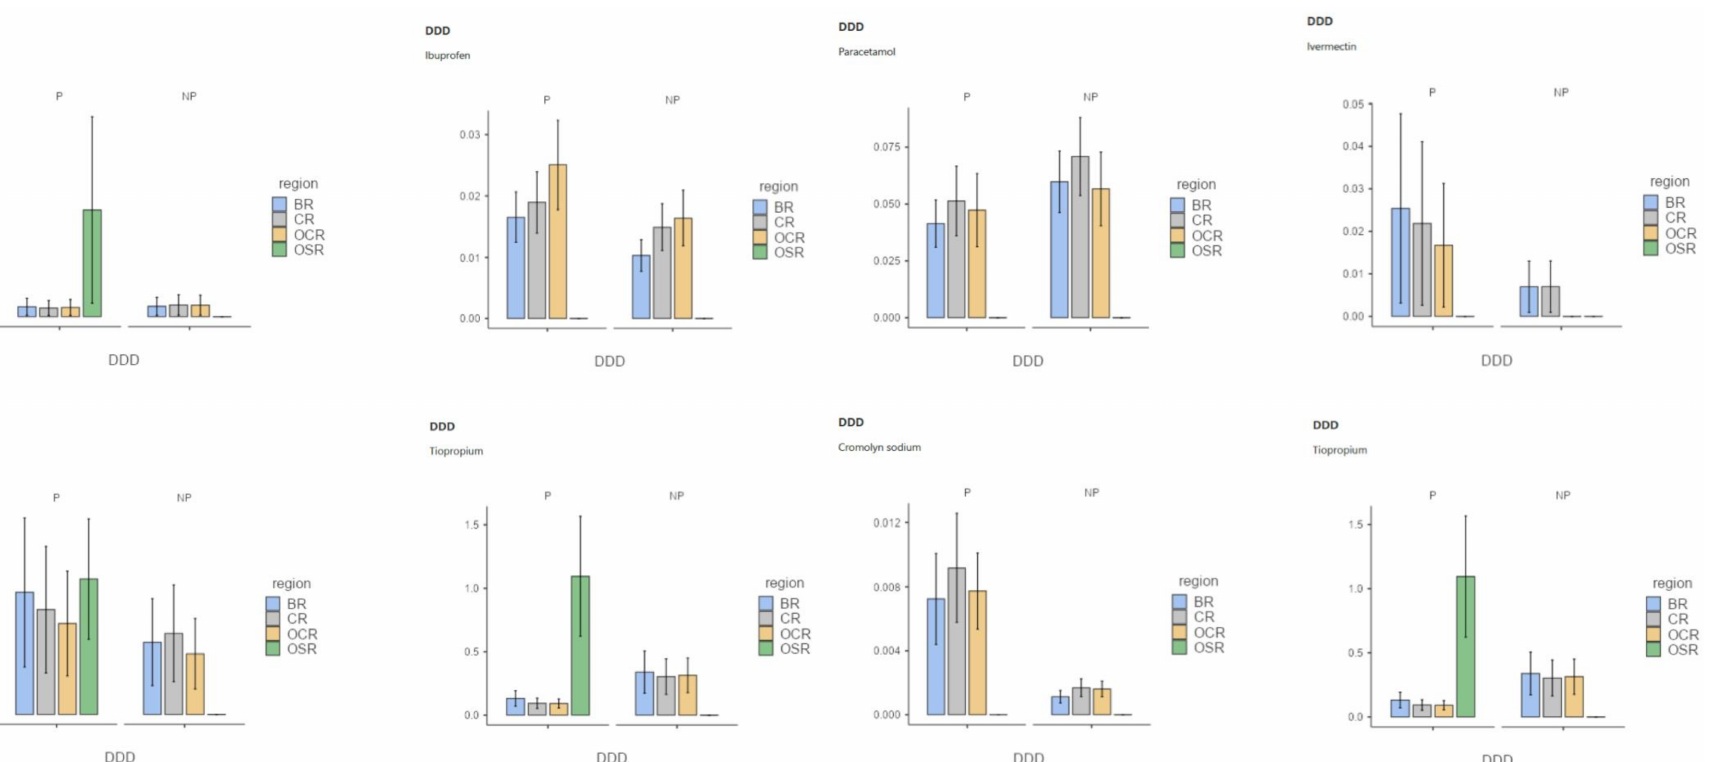
Figure A1. DDD distribution among precarious and non-precarious populations is shown for each tested molecule in each region (Note: DDD = defined daily doe; P = precarious populations; NP = non-precarious populations; BR = Brittany Region; CR = Centre Region; OCR = Occitany Region; OSR = Overseas